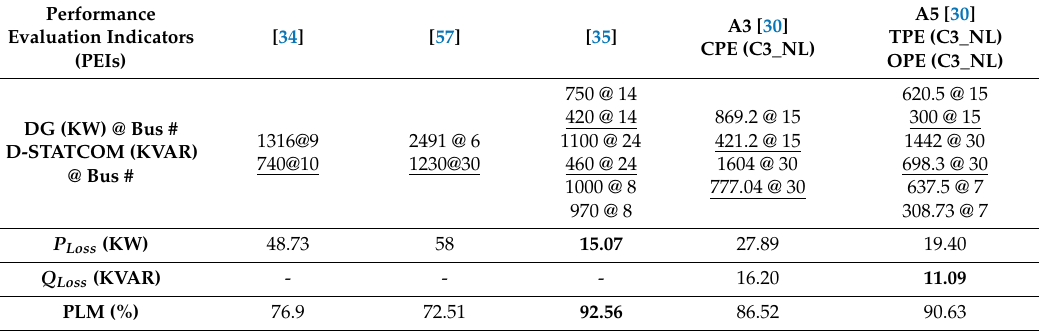
Table 32. Comparisons of results with C3_NL for 33-bus TDN (REG + D-STATCOM@LPF =